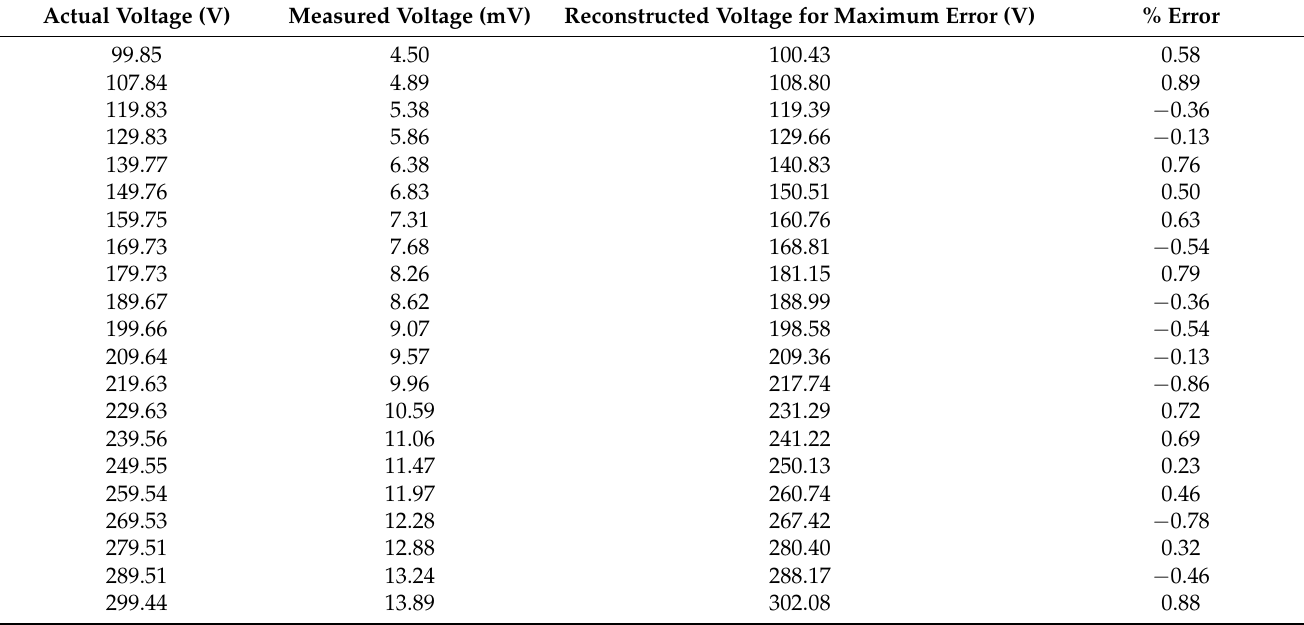
Table 6. Low voltage test results.